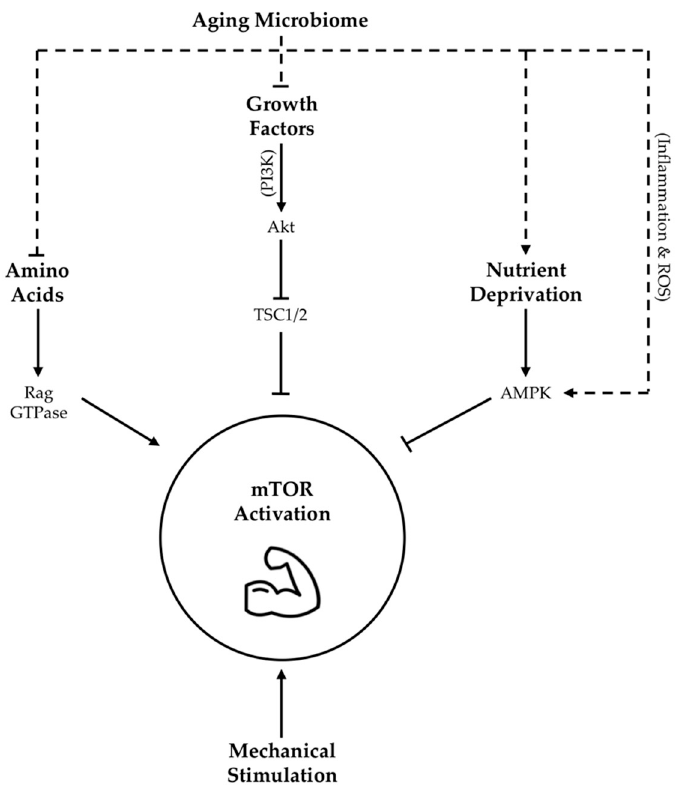
Figure 1. Proposed influence of age-related changes in gut microbiota on skeletal muscle mTOR signaling . Dotted lines indicate hypothesized contribution of aging microbiome changes to upstream regulators of mTOR activity, while solid lines indicate contributions as per literature consensus. TSC1/2 = tuberous sclerosis complex 1/2; Akt = protein kinase B, also abbreviated as PKB; AMPK = adenosine monophosphate activated protein kinase; ROS = reactive oxygen species; PI3K = phosphoinositide-3 kinase; GTPase = guanosine triphosphate-ase.